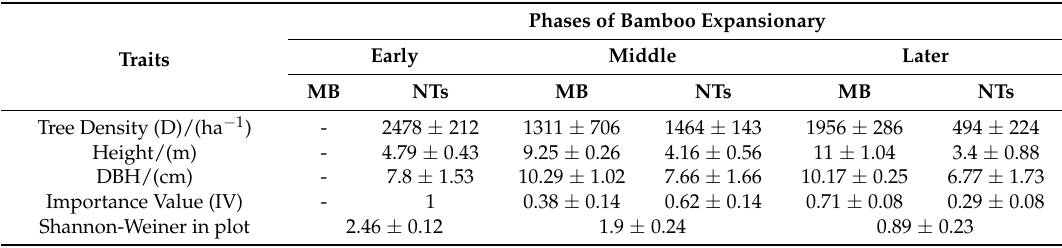
Table 2. Stand structure and composition in three expansionary phases of bamboo (values presented are means ± standard deviation in replicated plot level). MB: moso bamboo; NTs: native trees. Phases of Bamboo Expansionary Early Middle Later Traits MB